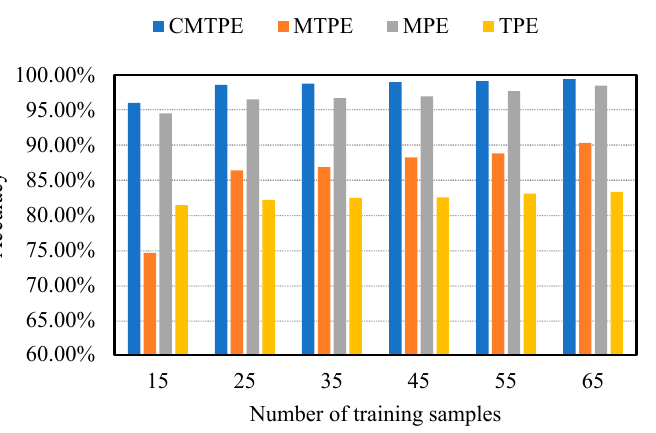
Figure 10. Confusion matrix of four methods.